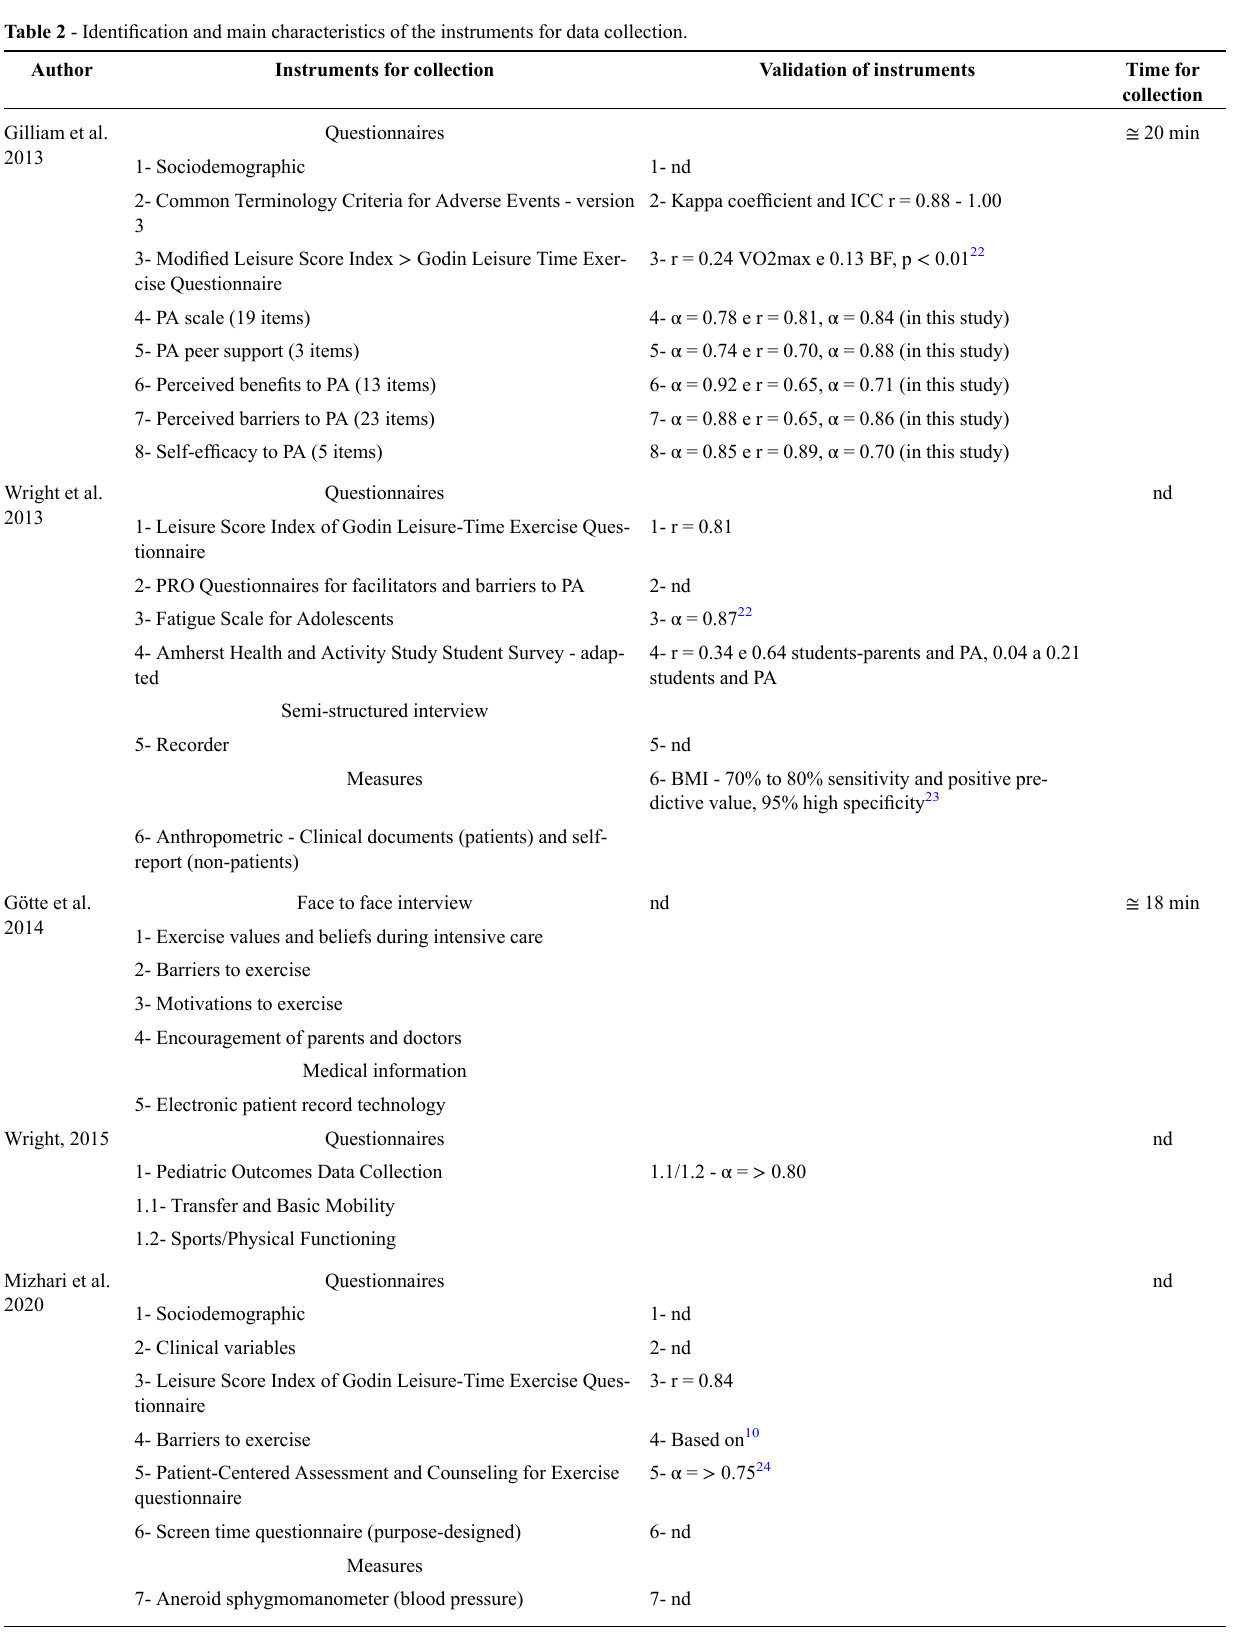
Table 2 - Identification and main characteristics of the instruments for data